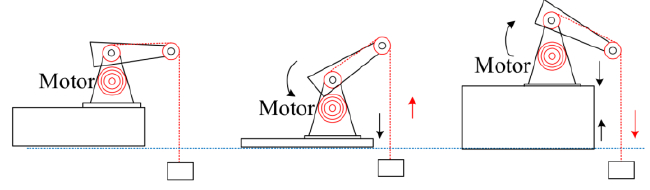
Figure 3. Boom luffing type